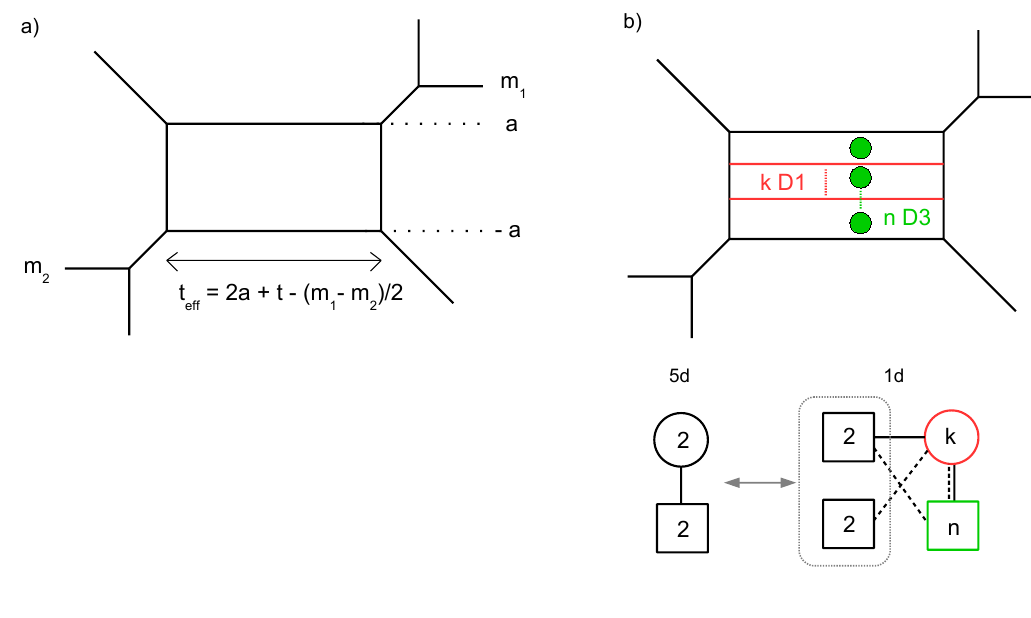
Figure 10 . a) Brane realization of the SU(2) theory with N f = 2 (with a 1 = (cid:0) a 2 = a ). b) Brane setup and ADHM quiver SQM for the k -instanton sector in the presence of an n D3 branes SQM loop.